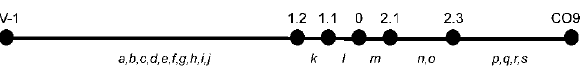
Figure 1. Phylogenetic relationships among the seven Y. pestis SNP genotypes identified in this study. Neighbor-joining tree was created using the data presented in Table 3 and MEGA2 software [23], and was rooted on genotype 0, as this genotype was assigned to the two outgroup isolates (see text). The position of the 19 SNPs (Table 1) are indicated below the tree. Individual genotypes or nodes were named